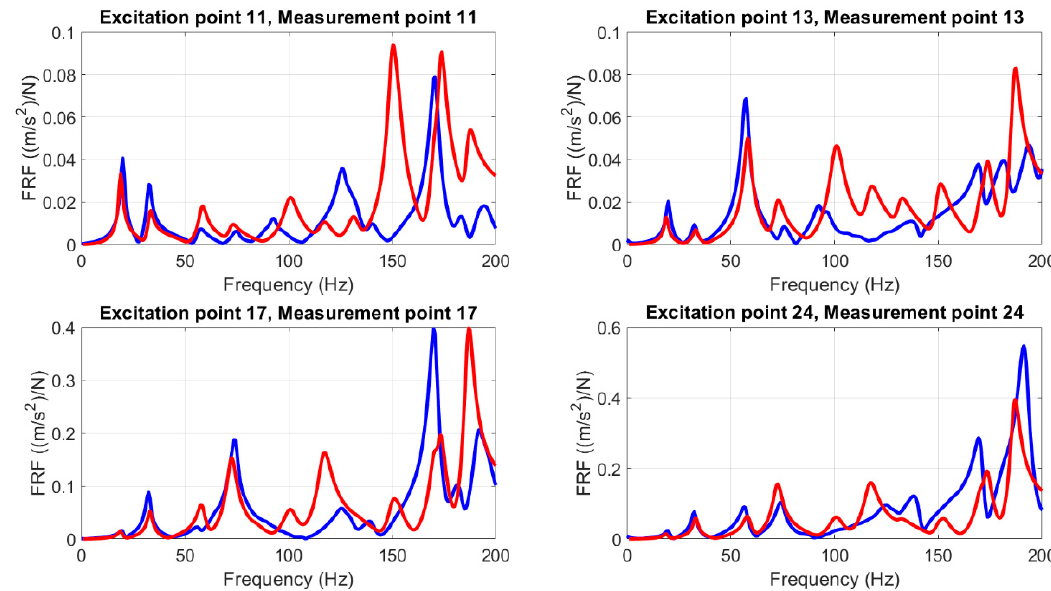
Figure 19. Magnitude of the complex mobility in the vertical direction of point 11, 13, 17, and 24. Simulated FRFs in red, measured FRFs in blue.